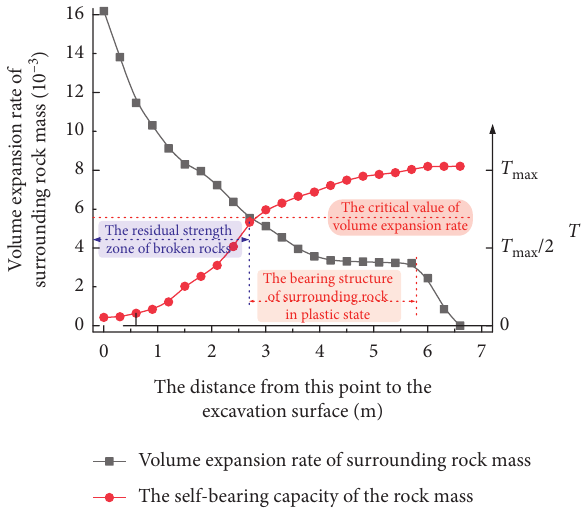
Figure 8: Relation curves between dilatation rate and self-bearing capacity of surrounding